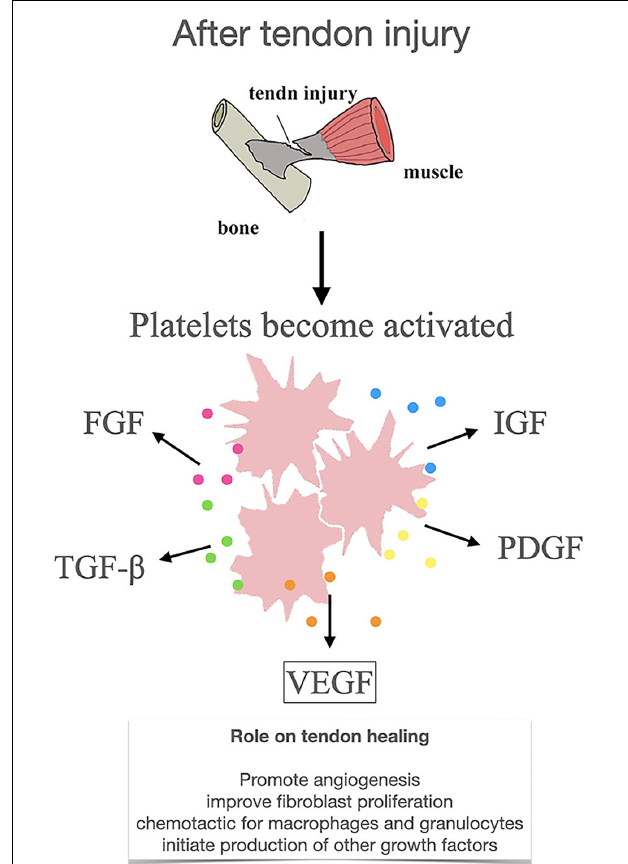
FIGURE 1 | Release and mechanism of action of VEGF after tendon injury. VEGF, vascular endothelial growth factor; TGF- β , transforming growth factor- β ; FGF, fibroblast growth factor; PDGF, platelet derived growth factor; IGF, insulin like growth